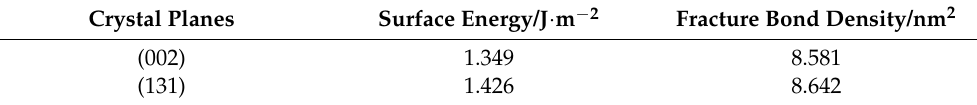
Figure 9. Calculation model of the fracture bond density of muscovite (002) and (131) crystal planes. Table 4. Surface energy and the fracture bond density of muscovite (002) and (131) crystal